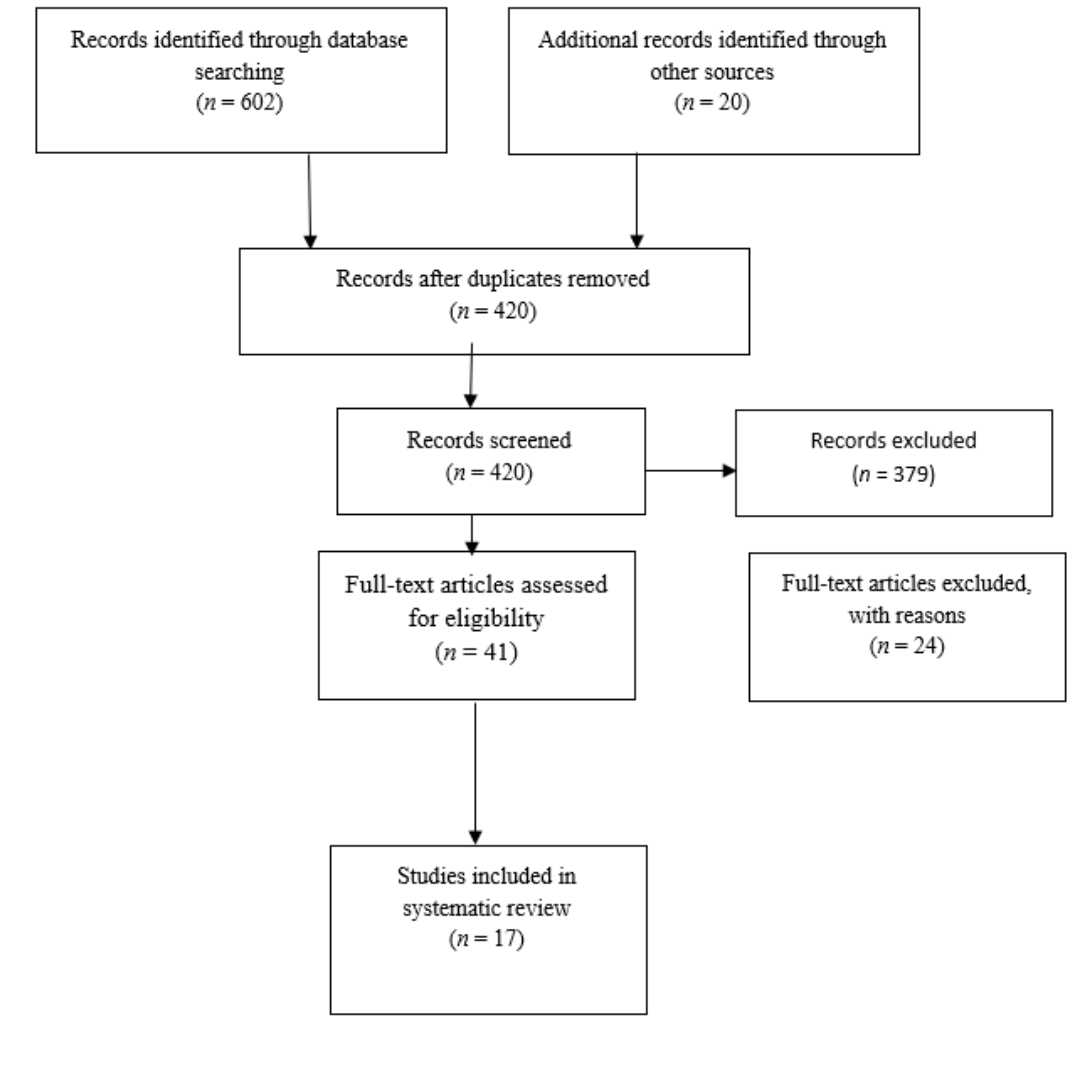
Figure 1. PRISMA flow Diagram.